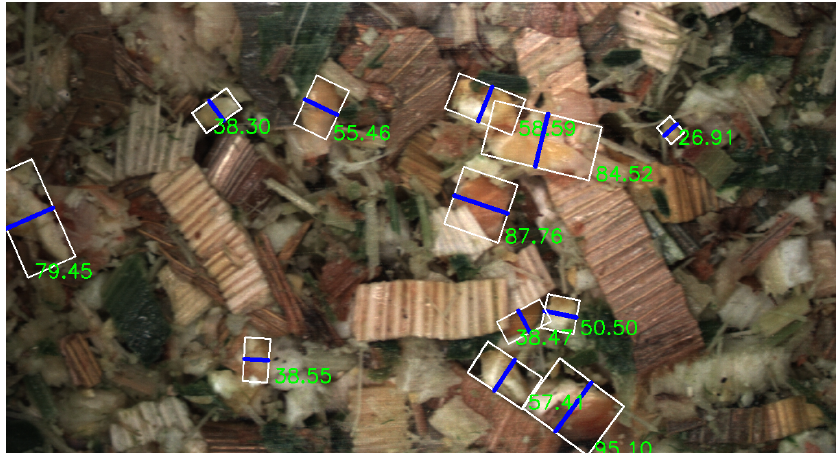
Figure 9. Visualisation of determining kernel processing based on the shortest axis length of a rotated bounding-box for a number of annotated kernel fragments. The shortest axis is shown via a blue line with the length in pixels for each shown next to the